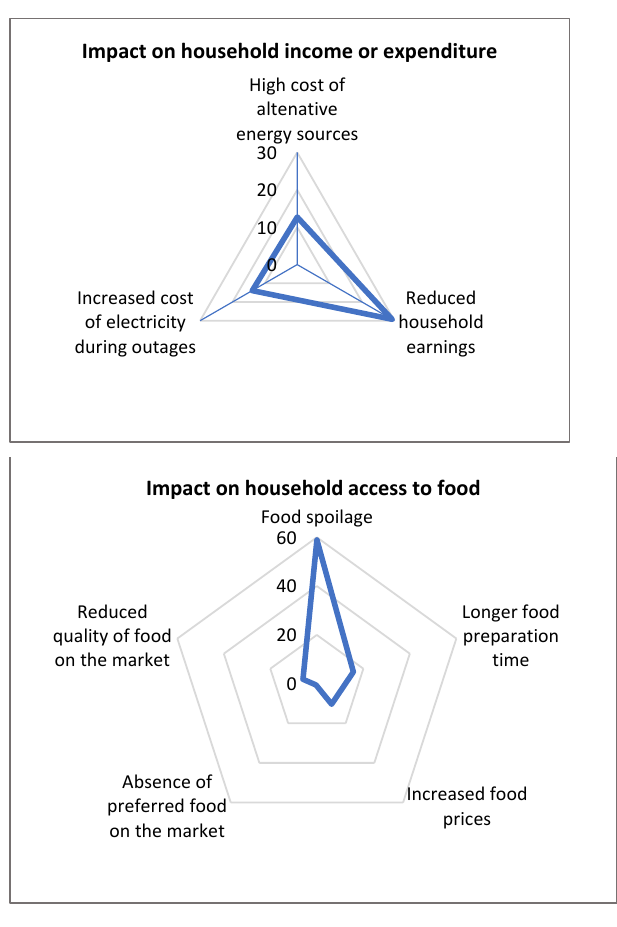
Figure 3. Reported impacts of electricity outages in percent of households.